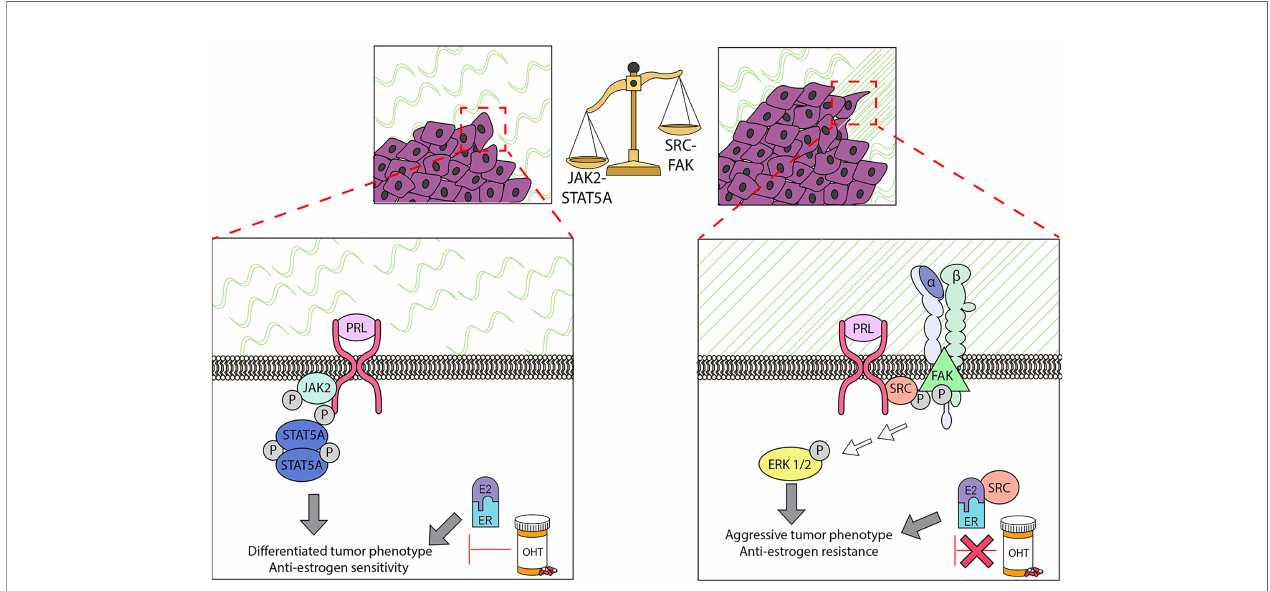
FIGURE 2 | PRL can initiate multiple signaling cascades in established cancers, which can result in different biological outcomes. Determination of the repertoire of PRL signals can be modulated by multiple factors, including properties of the ECM. In ER+ cell lines, the stiffness and density of the extracellular matrix (ECM) strongly in fl uences the balance of these signals: in stiff matrices, PRL signals are shifted away from the canonical JAK2/STAT5A pathway, and toward FAK/SFK/ ERK1/2. This shift permits PRL to drive proliferation, invasion, and resistance to tamoxifen (OHT), and further remodel collagen fi bers in the ECM. These experimental fi ndings support the clinical observations that ER+ cancers with regions of aligned collagen perpendicular to the tumor boundary have a worse prognosis, and that activated STAT5A is strongly linked to more differentiated cancers and tamoxifen sensitivity. See Section 3.4 for